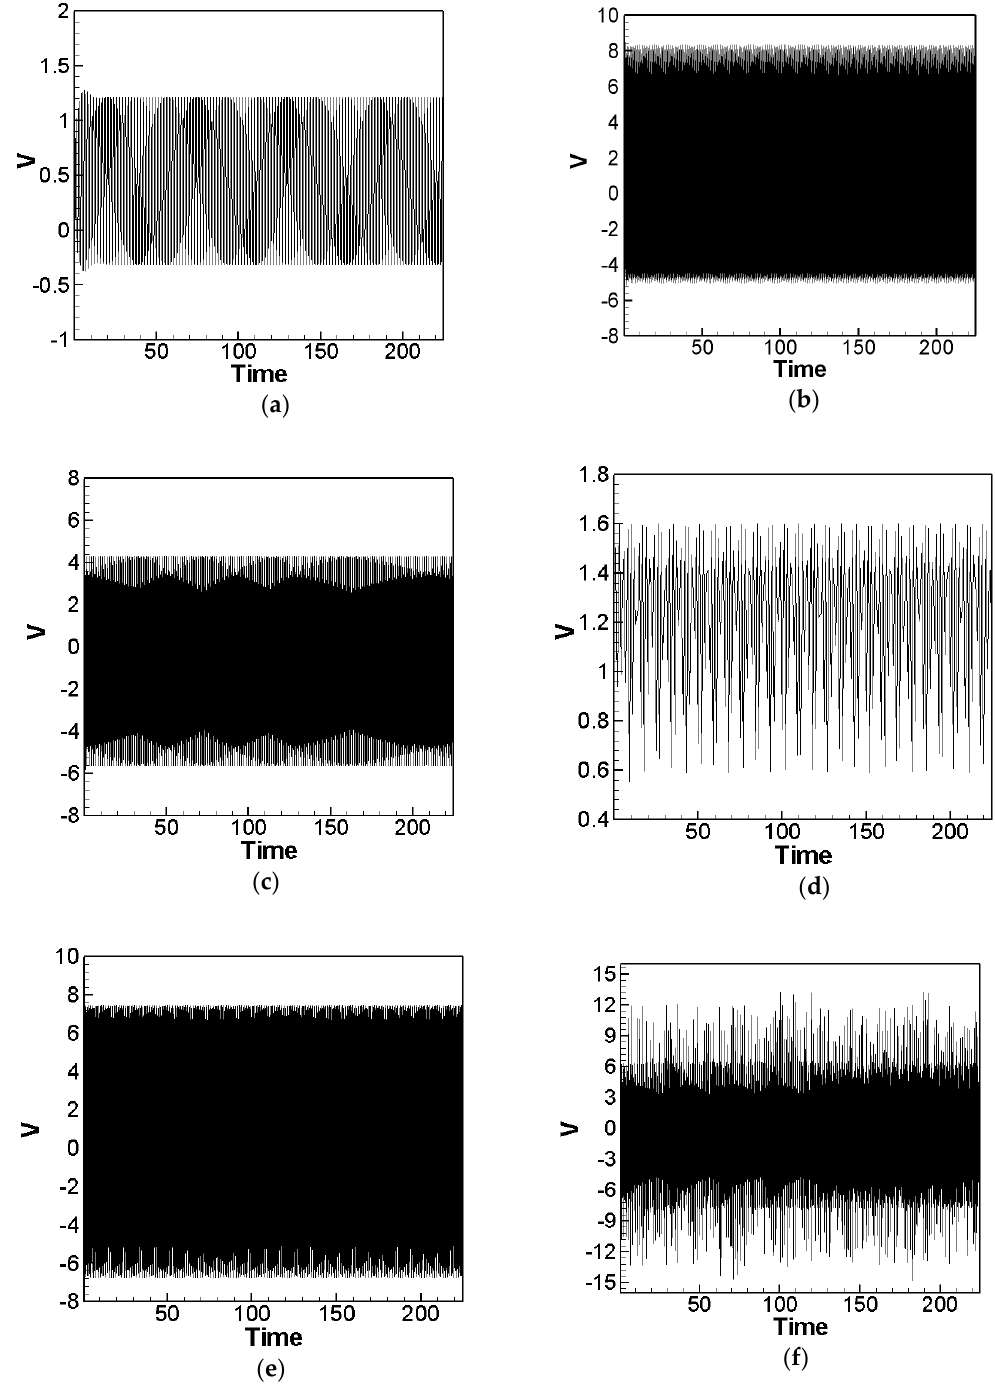
Figure 15. Nonlinear numerical simulation of AC voltage,( a ) SESS 1st mode, ( b ) SESS 2nd mode, ( c ) SESS 3rd mode, ( d ) DESS 1st mode, ( e ) DESS 2nd mode, ( f ) DESS 3rd mode.